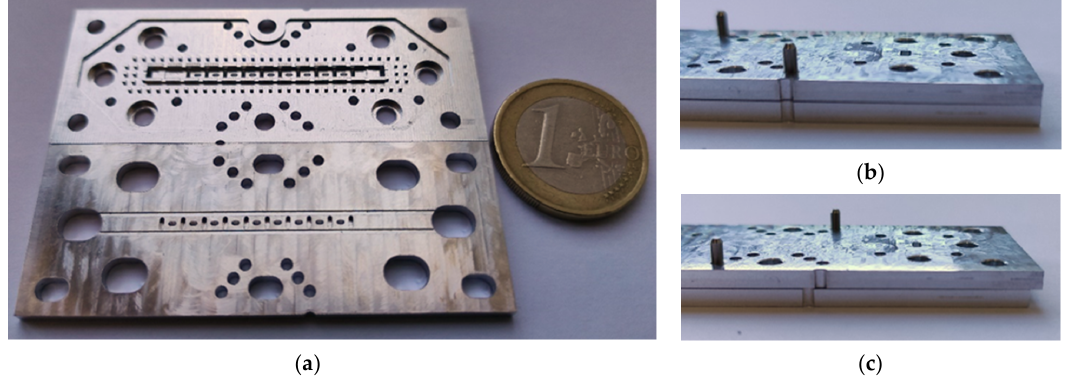
Figure 31. Manufactured single-periodic prototype. ( a ) Inner view of top and bottom pieces, ( b ) pieces in glide-symmetric configuration and ( c ) pieces in broken symmetry configuration.